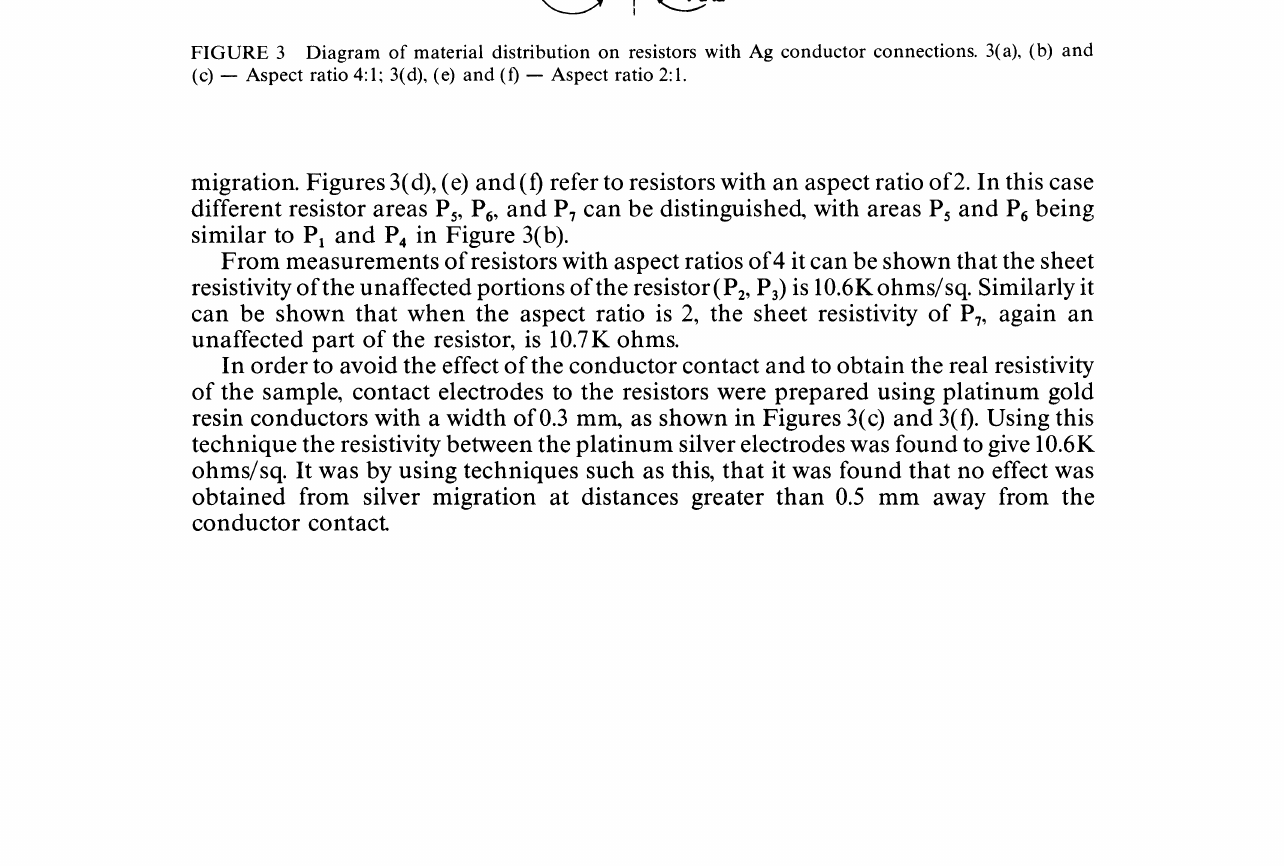
FIGURE 3 Diagram of material distribution on resistors with Ag conductor connections. 3(a), (b) and (c) Aspect ratio 4:1; 3(d), (e) and (f) Aspect ratio